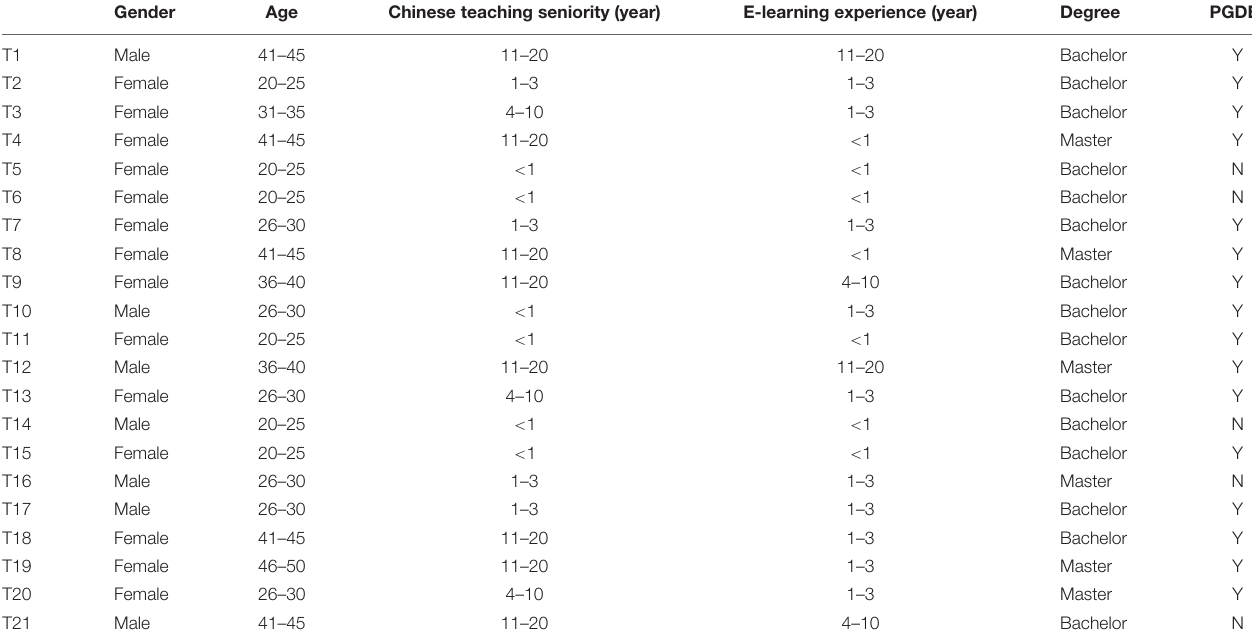
TABLE 1 | Composition of the